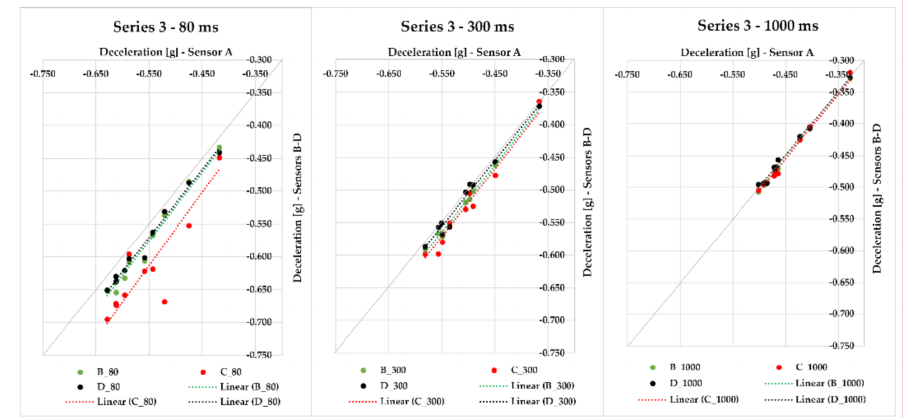
Figure 9. Series 3-A Point Dependency of Individual MEMS Sensors against Sensor A.